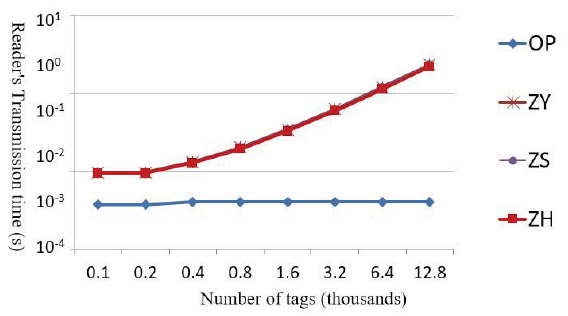
Figure 10. Comparisons of transmission load of the